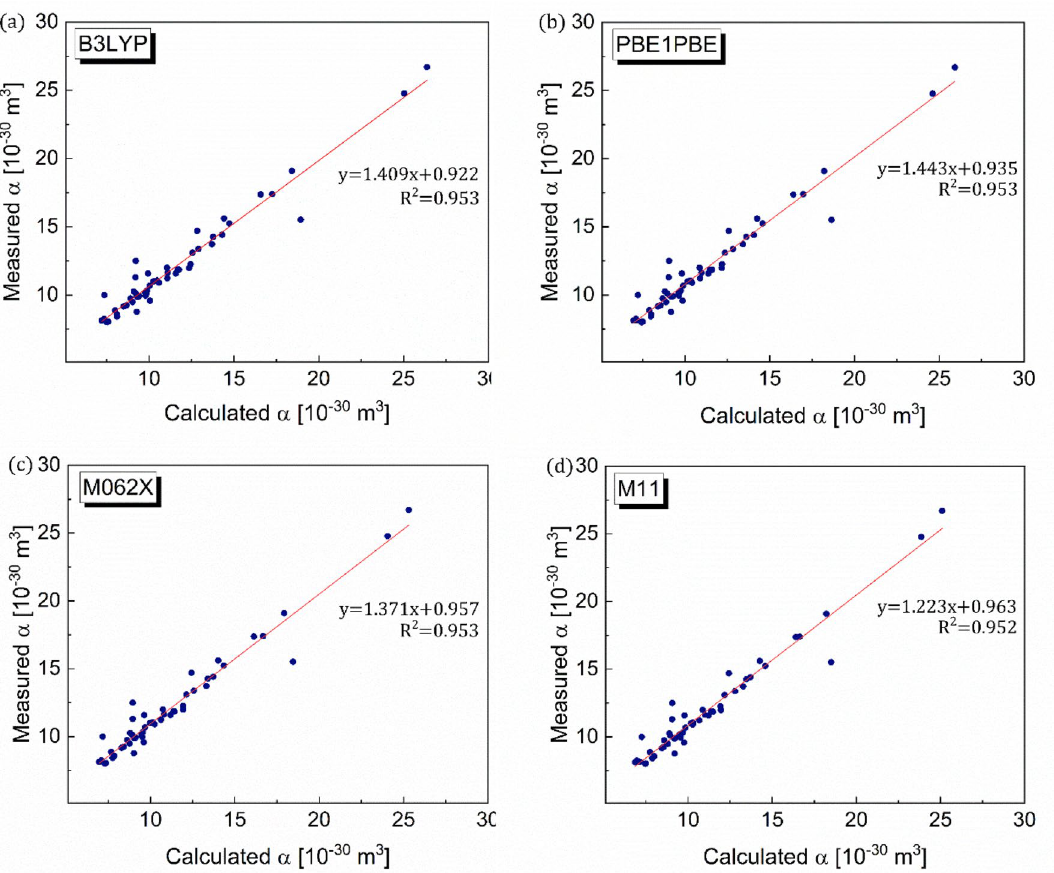
Figure 2. Validation of DFT method for polarizability. Comparisons between DFT-computed and measured polarizability (α) values for four different DFT functionals, viz . ( a ) B3LYP, ( b ) PBE1PBE, ( c ) M062X, and (d) M11.